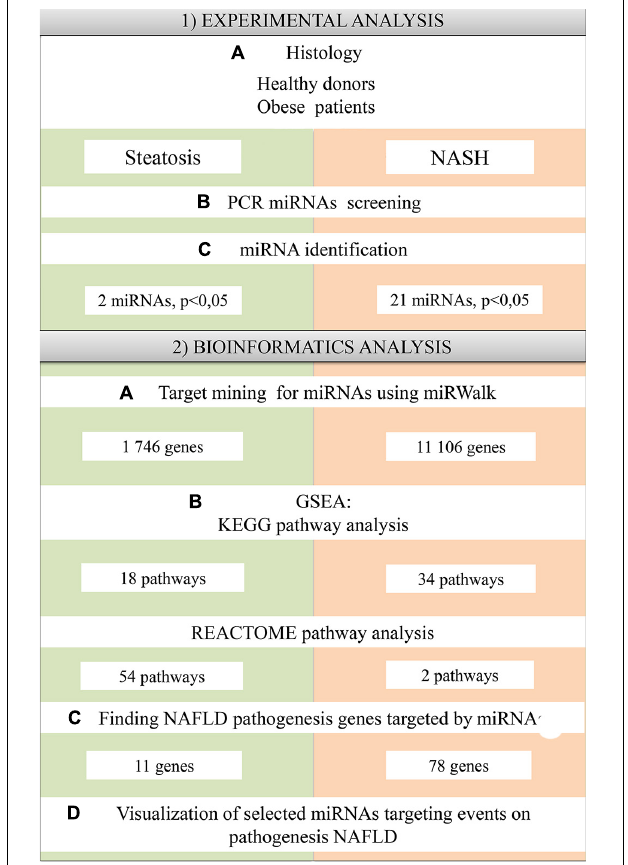
FIGURE 1 | Schematic representation of the study